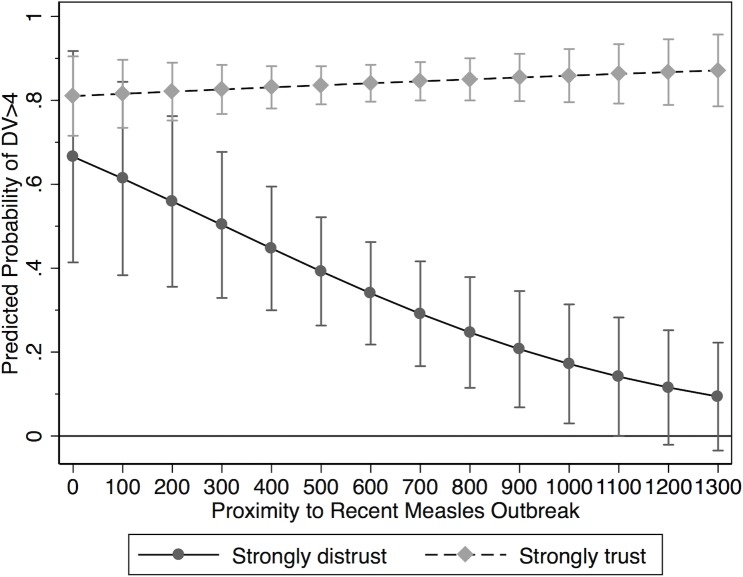
Predicted score.